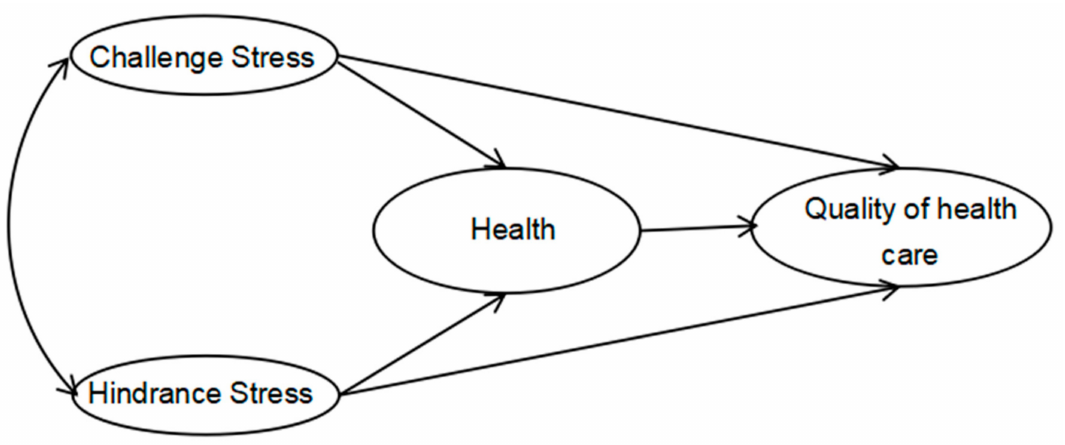
Figure 1. Proposed model of how challenge stress, hindrance stress, and health affect the quality of health